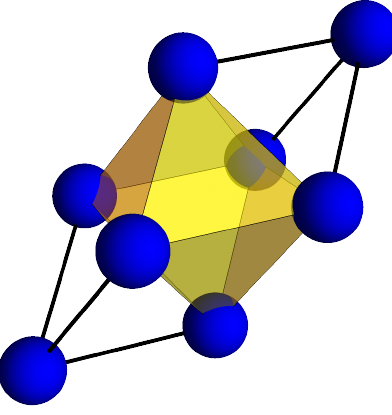
Figure 10. The octahedral coordination may be built from tetrahedra decorating the opposite faces of an